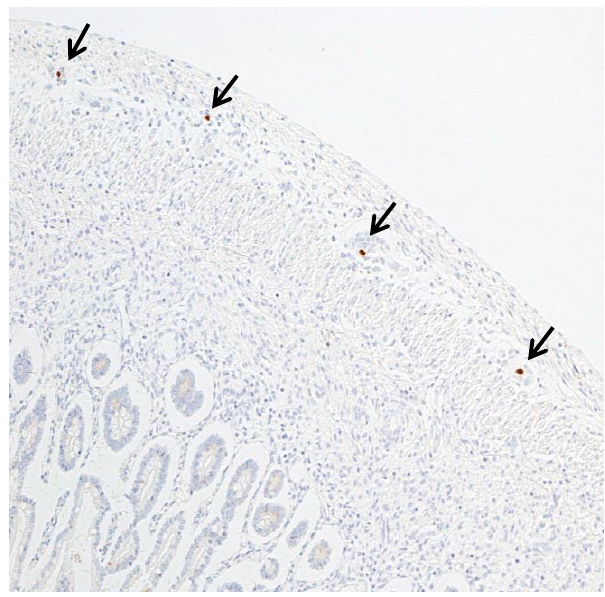
Figure 3. Multiple ganglion cells in Auerbach’s myenteric plexus were CMV-positive (arrows) (CMV-IHC; 2HPF).